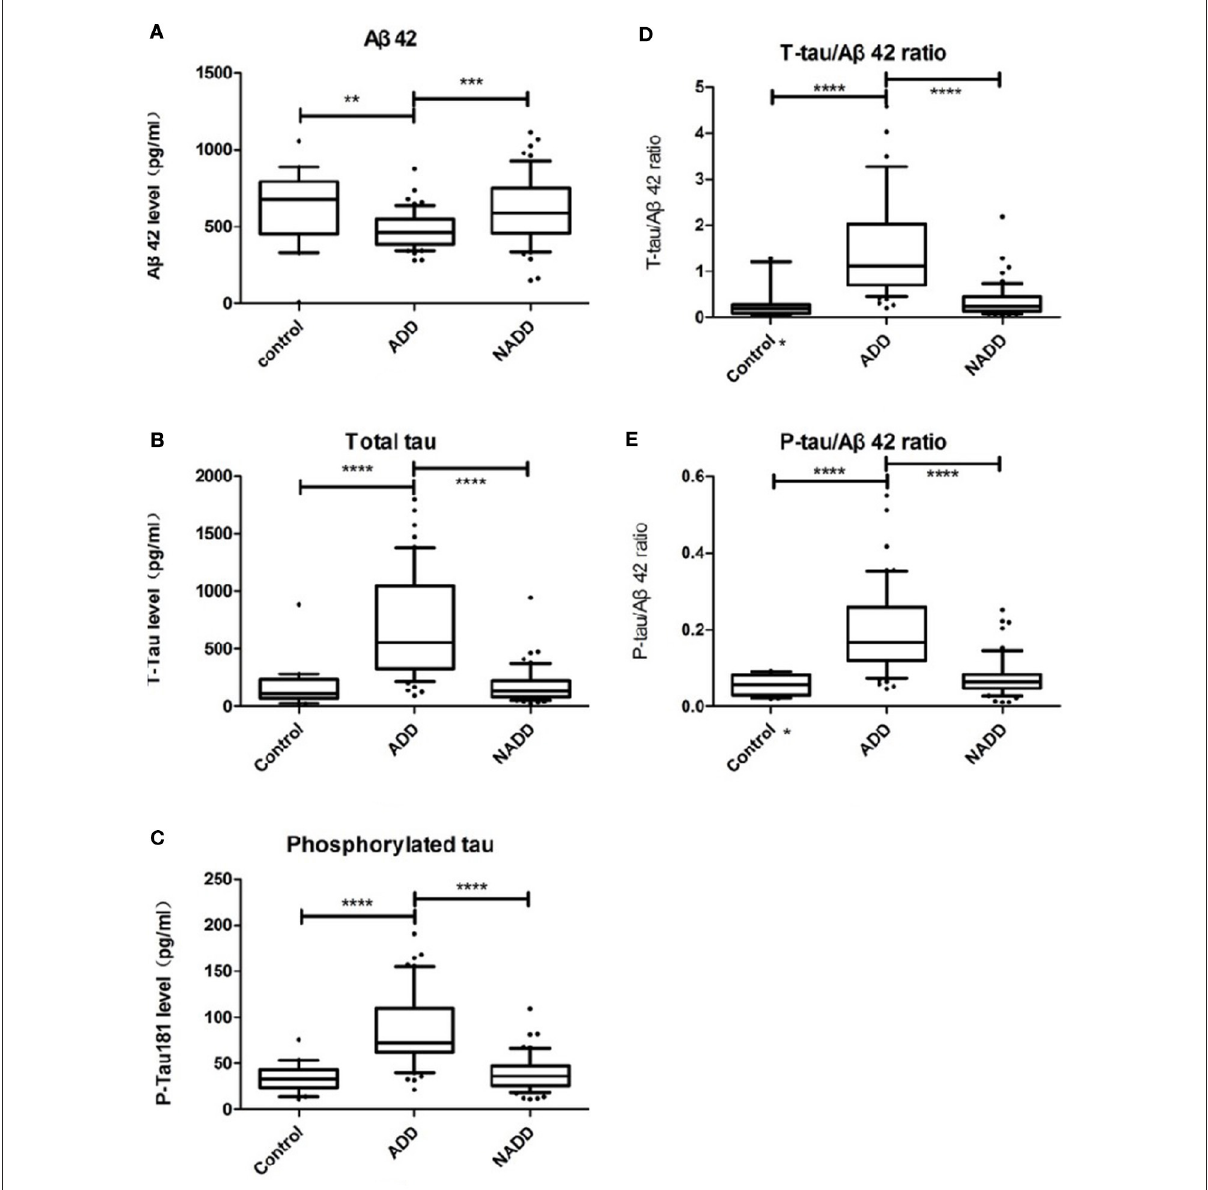
FIGURE2 Comparison of CSF biomarker levels across groups. (A–E) Display A β 42, t-tau, p-tau, t-tau/A β 42, p-tau/A β 42 distributions of the three groups respectively. Box plots present median and interquartile range and whiskers indicate 10–90% interval. In graph (D, E) asterisk markers (*) on X axis indicate that there is an outlier value beyond the upper limit. ADD, AD dementia; NADD, non-AD dementia. ** P < 0.01; *** P < 0.001; **** P < 0.0001, between the two groups linked.